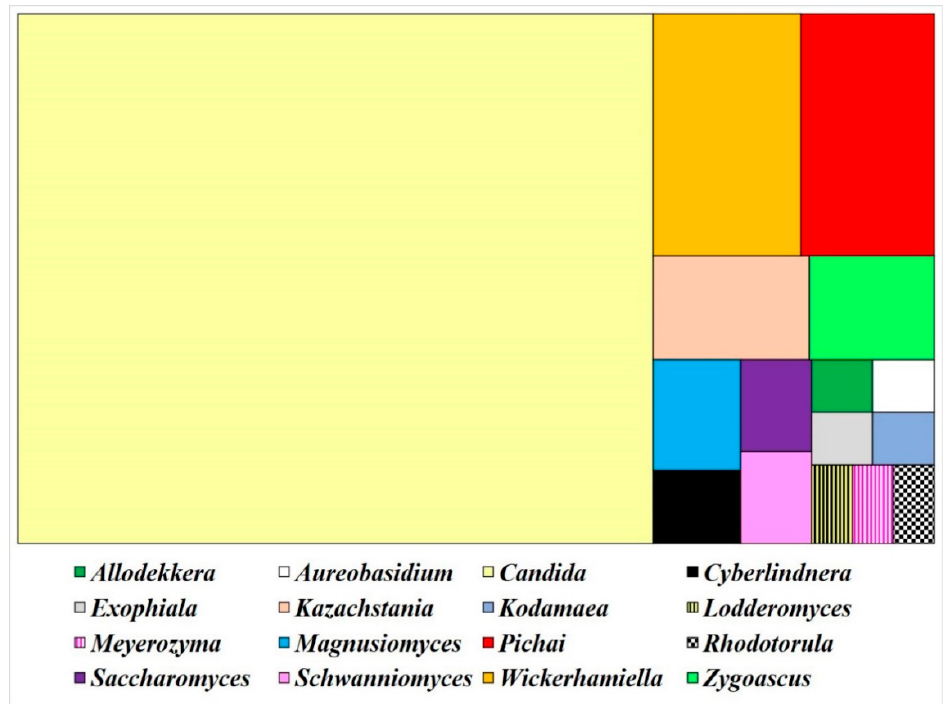
Figure 1. Proportion of yeast genera discovered in grease traps. Table 1. Summary of described yeast discovered in grease traps.